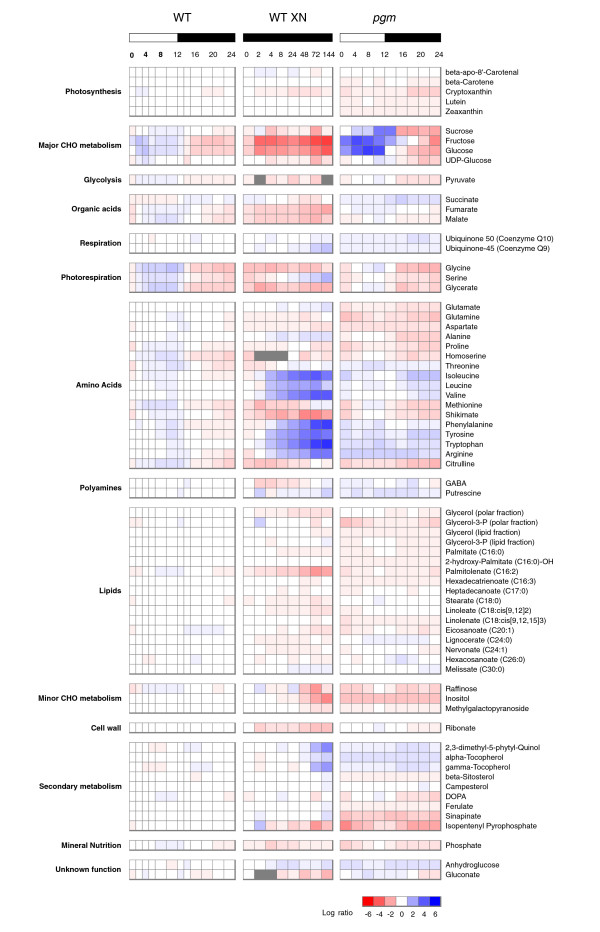
Heat map representing the changes in metabolites throughout one day and night cycle in rosettes of Arabidopsis Col0 WT plants, in Col0 pgm growing in a 12 h night and day cycle, and in WT plants transferred to an extended night (XN). Log2 ratios were calculated for each value by dividing it by the average of diurnal WT values and applying the logarithm (base 2). Log2 ratios give the intensity of the blue or red colors, according to the scale bar. CHO, carbohydrate.